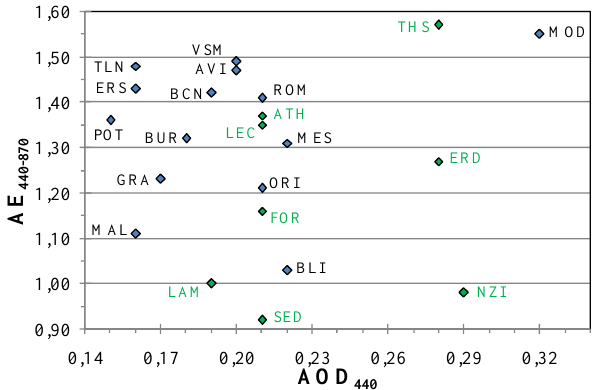
Fig. 2. Average AERONET level 2 aerosol Angström Exponent and optical depth of the 22 selected stations. The 8 stations in green are relevant of the eastern Basin (see Table 1 for the station